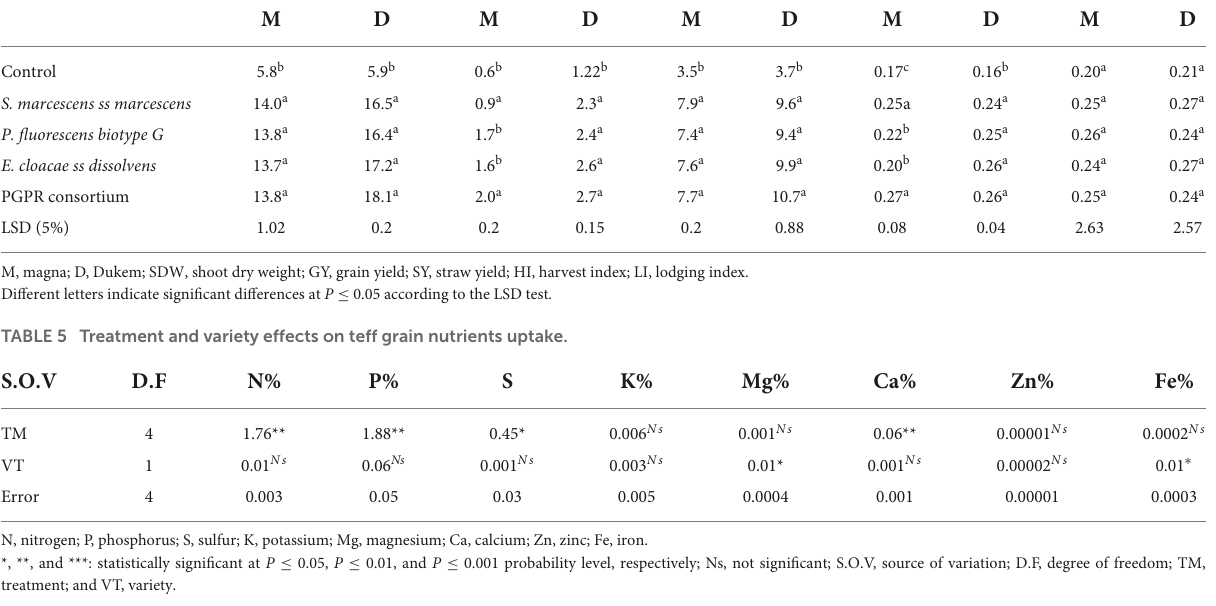
TABLE 4 Effect of PGPR inoculation on teff varieties yield and yield-related traits. Treatment